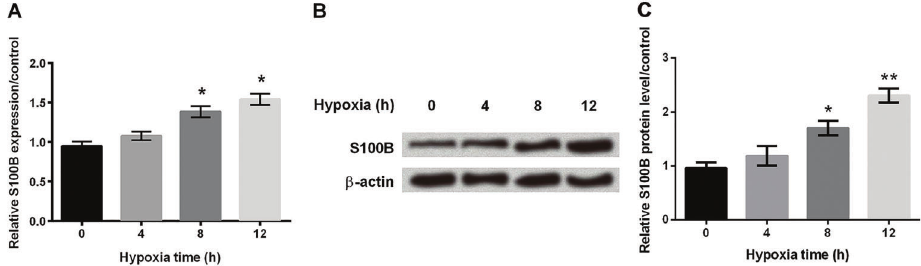
Figure 2. A , mRNA expression of S100B was determined by qRT-PCR at different times in hypoxic astrocytes. B and C , Western blot was performed to assess the protein expression of S100B at different times in hypoxia astrocytes. b -actin acted as an internal control. Data are reported as means ± SD. *P o 0.05, **P o 0.01 compared to 0 h (ANOVA).